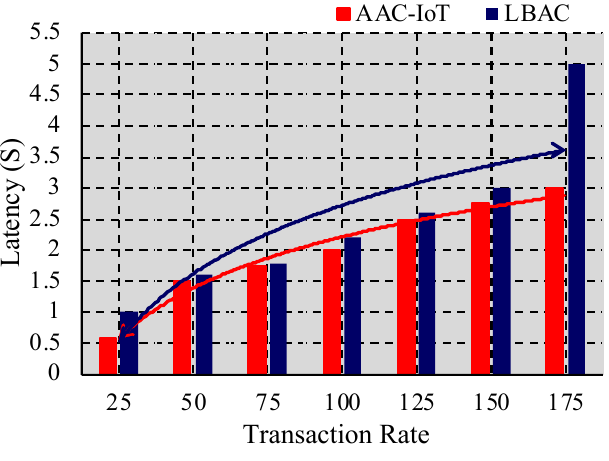
Figure 10. Performance of latency plot against rate of